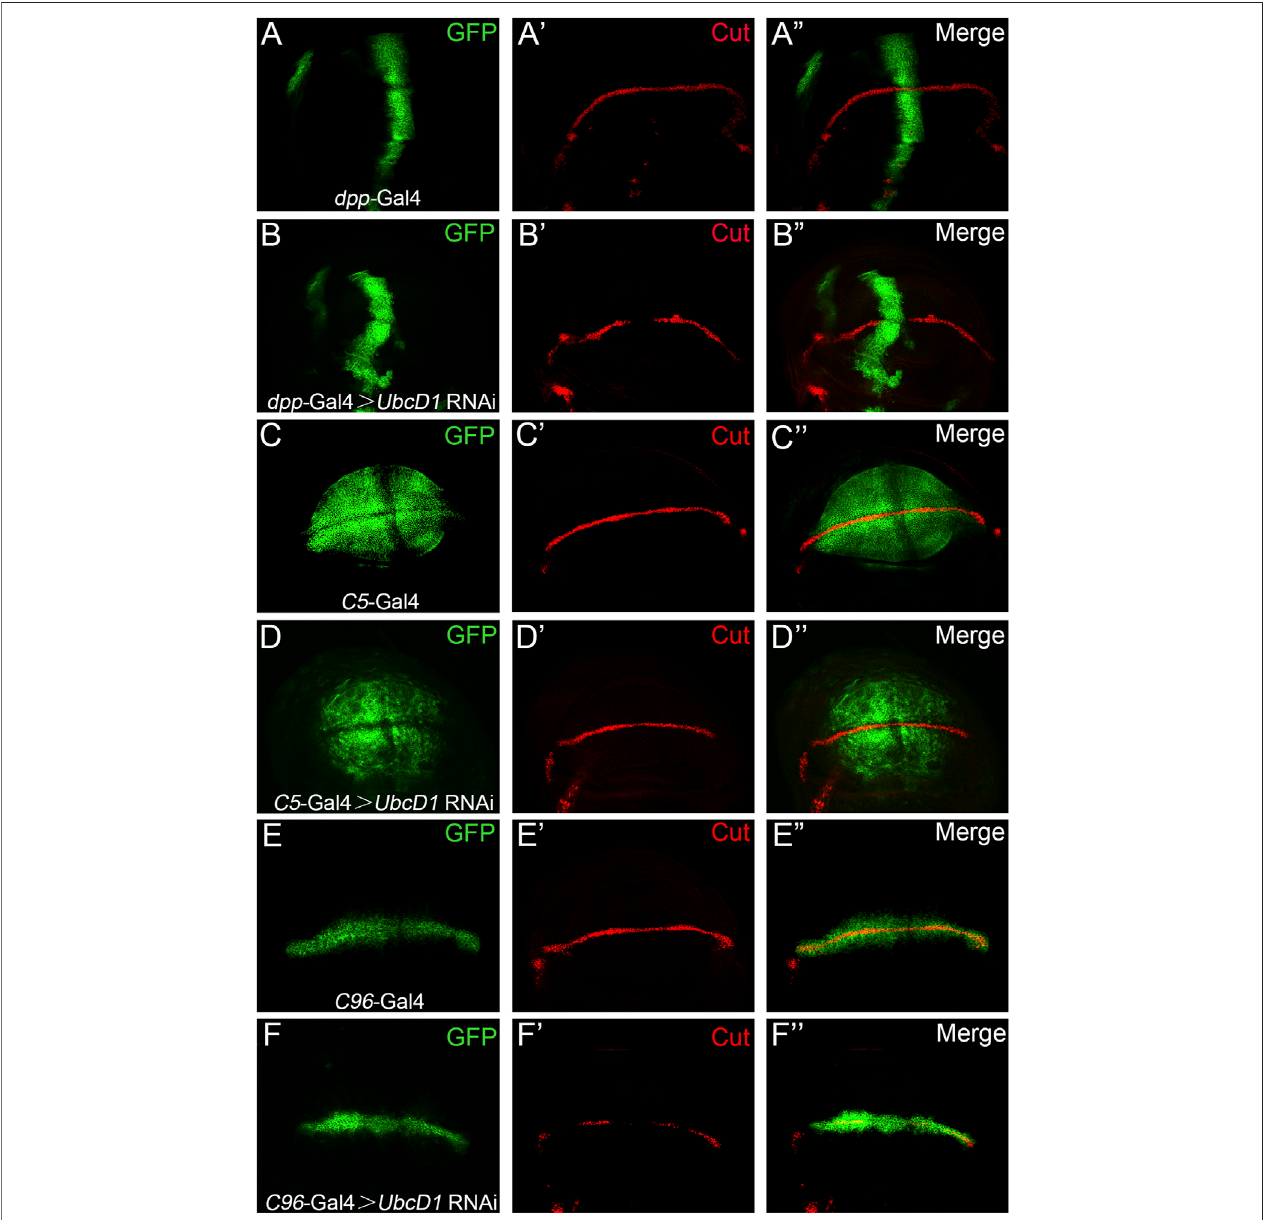
FIGURE 3 | UbcD1 knock-down in the signaling receiving cells inhibit Notch activity. (A – B) When driven by dpp -Gal4 in the anterior-posterior border region (A) , UbcD1 RNAileadstoreductionofCutexpression (B) . (C – D) The C5 -Gal4drivesGFPexpressioninthesignal-sendingcells (C) .ExpressionofCutarenotaffectedwhen UbcD1 RNAi are driven by the C5 -Gal4 (D) . (E – F) The C96 -Gal4 expression domain is restricted within the signal-receiving cells (E) . Knocking-down UbcD1 in the signal-receiving cells by C96 -Gal4 disrupts Cut expression (F) . The Gal4 expression domain are marked by